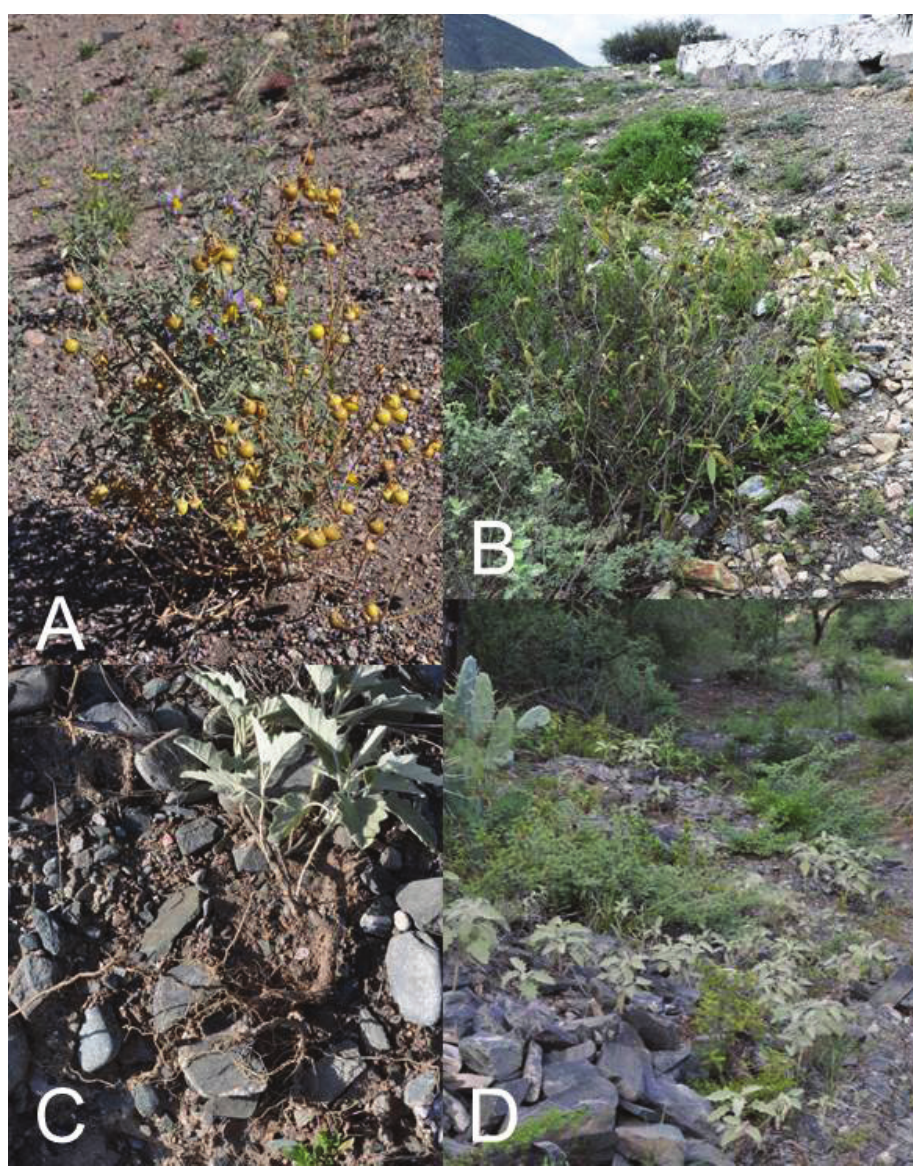
Figure 4. Habitats of members of the Elaeagnifolium clade. A Solanum elaeagnifolium , old stems with persistent berries and young new stems from underground rhizomes (Argentina, Mendoza, Knapp et al. 10470 ) B Solanum houstonii on rocky slope (Mexico, Querétaro, Ochoterena et al. 976 ) C Solanum mor- tonii , plant dug up showing extensive underground stems (Argentina, Catamarca, Barboza et al. 3437 ) D Solanum mortonii , large population on rocky slopes (Argentina, Catamarca, Barboza et al. 3437 ). Pho- tographs by S.